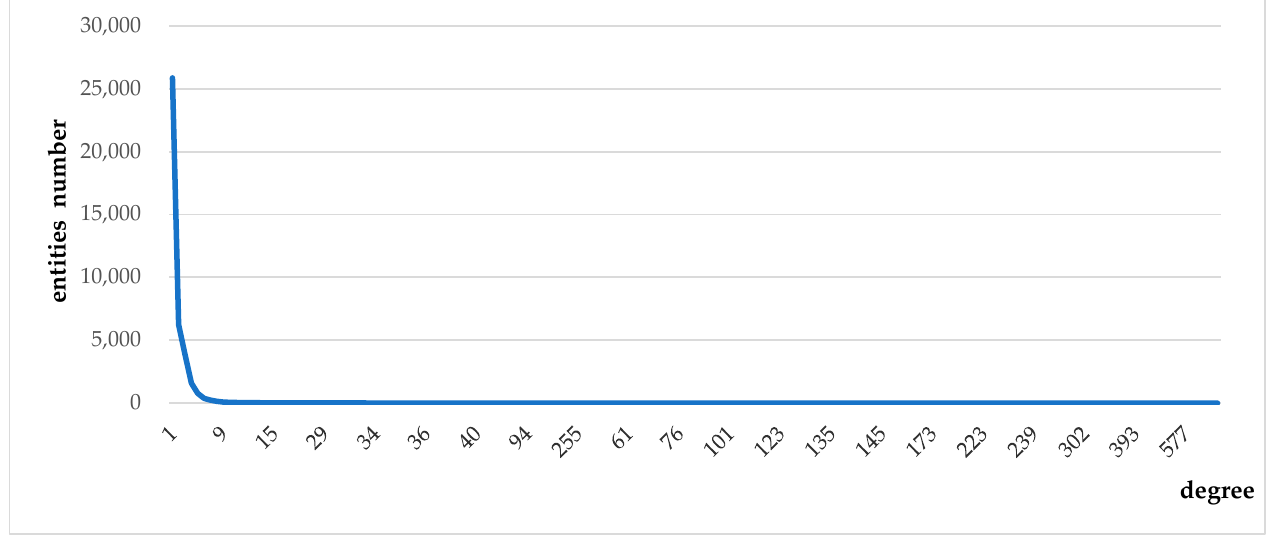
Figure 7. Number of all relationship types appearing in the GeoDBpedia21 dataset. Details of the geo-entities in the GeoDBpedia21 dataset are shown in Figure 8; 25,872 geo-entities have just one degree, which represents the number of other geo-entities con- nected to the given entity from a KG aspect, as well as the number of edges connected with this node from a graphical aspect. Most geo-entities have a degree < 8, and the number of geo-entities varies from 10 to 1 when the degree is >20. Thus, unbalanced distribu- tion of geo-relations and weak connectivity between geo-entities Objectively exists in the GeoDBpedia21 dataset. A similar pattern is expected for large-scale GeoKG whose data are from complex Internet resources. This unbalanced distribution of relations is visualized in Figure 9, where it can be seen that many geo-entities have little connection to other geo-entities around the boundary in the graph.